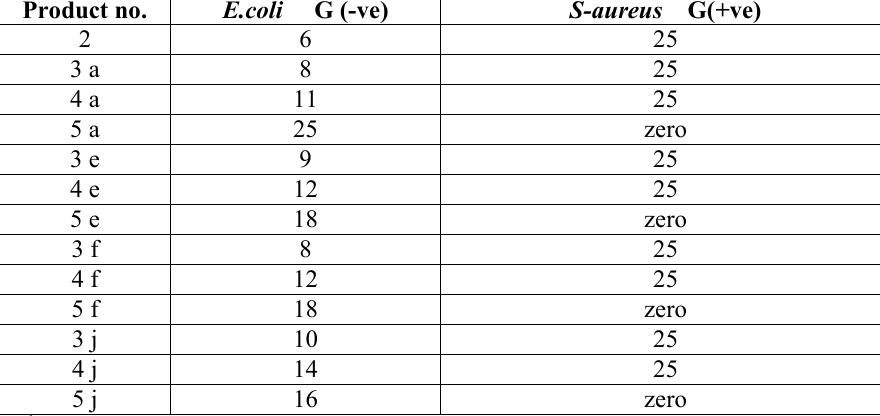
Table-5 : Anti-bacterial activity of some prepared chalcones and pyrazolines with inhibition zone diameters in (mm) scale against S-aureus and E-coli bio-organisms. Product